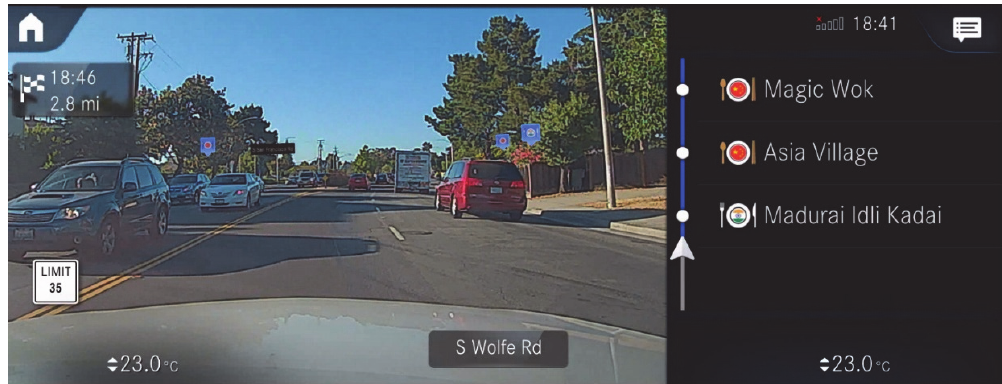
Fig 2. Point-of-interest display sample within augmented reality system. By clicking on the respective icons users can access context data like webpages, telephone numbers or – for more distant objects – start a route guidance. Image courtesy of Daimler